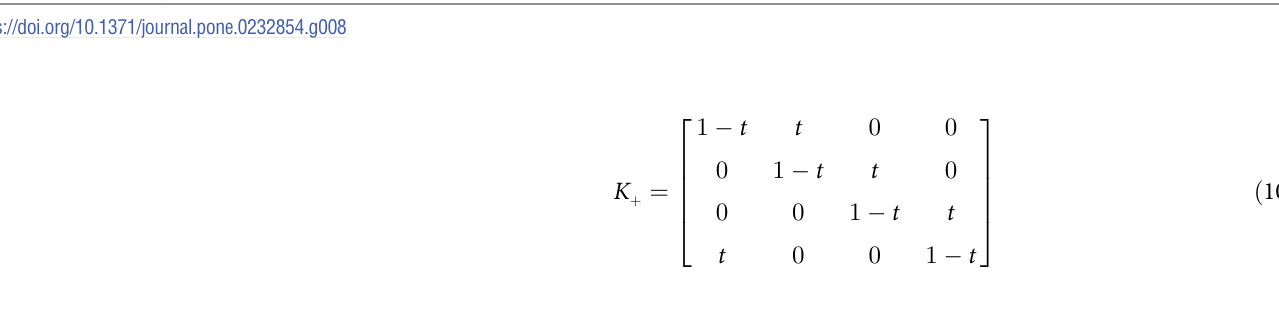
Fig 8. Operations of the first stage of EAS method for quadrilateral mesh. a) shows EAS transformation for quadrilateral mesh when t is 0.25; b) shows EAS transformation for pentagonal mesh when t is